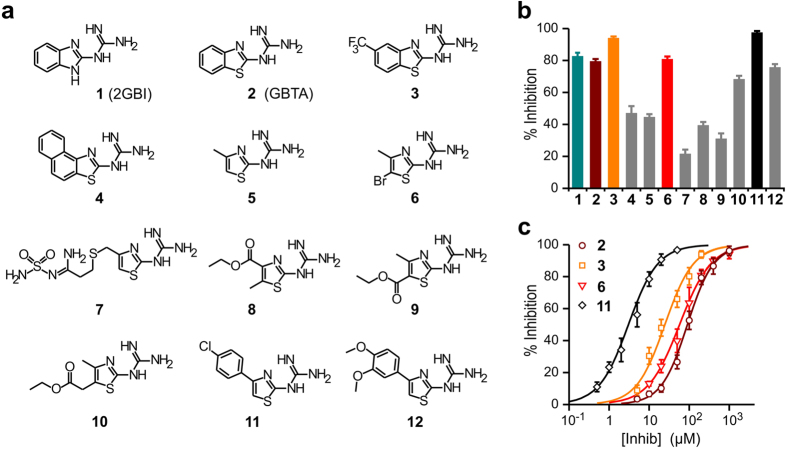
Hv1 inhibition by guanidinothiazole derivatives.(a) Tested compounds: [1] reference Hv1 inhibitor 2-guanidino-benzimidazole (2GBI). [2] 2-guanidino-benzothiazole (GBTA), [3] (5-trifluoromethyl-1,3-benzothiazol-2-yl)guanidine, [4] naphtho[1,2-d][1,3]thiazol-2-yl-guanidine, [5] (4-methyl-1,3-thiazol-2-yl)guanidine, [6] (5-bromo-4-methyl-1,3-thiazol-2-yl)guanidine, [7] famotidine, [8] ethyl 2-guanidino-5-methyl-1,3-thiazole-4-carboxylate, [9] ethyl 2-guanidino-4-methyl-1,3-thiazole-5-carboxylate, [10] ethyl (2-guanidino-4-methyl-1,3-thiazol-5-yl)acetate, [11] 1-[4-(4-chlorophenyl)-1,3-thiazol-2-yl]guanidine, [12] 1-[4-(3,4-dimethoxyphenyl)-1,3-thiazol-2-yl]guanidine. (b) Inhibition of human Hv1 activity by the indicated guanidinothiazoles and reference compound 2GBI (teal column). Hv1 proton currents were measured in inside out patches from Xenopus oocytes in response to depolarizations to +120 mV from a holding potential of −80 mV. Each inhibitor was added to the bath solution at a concentration of 200 μM. pHi = pHo = 6.0. Data are means ± S.E.M. (n ≥ 4). (c) Concentration dependences of inhibition of human Hv1 by compounds [2], [3], [6], and [11]. Each point represents the average inhibition from 3 to 15 measurements ± S.D. Curve lines are Hill fits used to obtain the apparent Kd values reported in Supplementary Table 1. Hill coefficients were determined from fits reported in Supplementary Fig. 1: h(1) = 0.975 ± 0.024 h(2) = 1.306 ± 0.033, h(3) = 1.25 ± 0.07, h(6) = 1.109 ± 0.040, h(11) = 1.179 ± 0.036 (see methods).